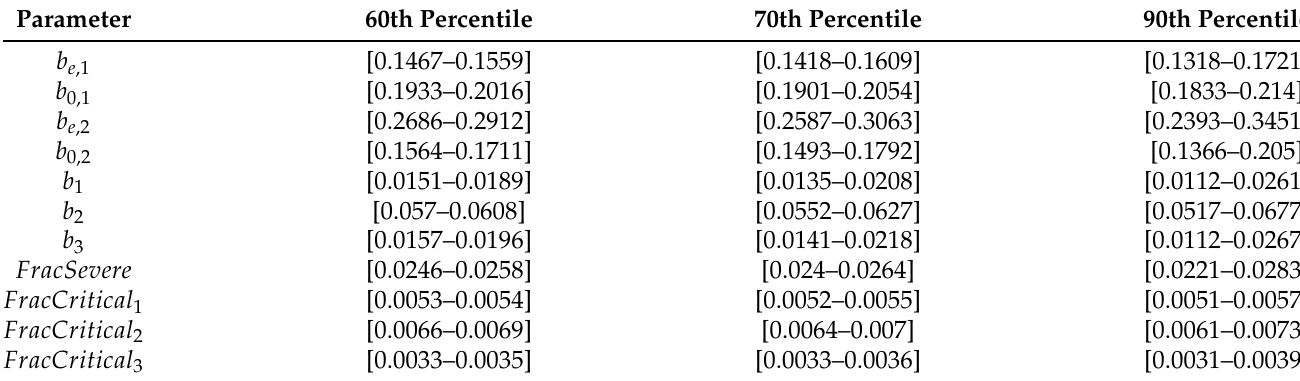
Table A2. CRC results for Italy. The columns show the 60th, 70th, and 90th percentile of the probability density function (pdf) of the parameter vector returned by CRC in the last iteration, for one of the